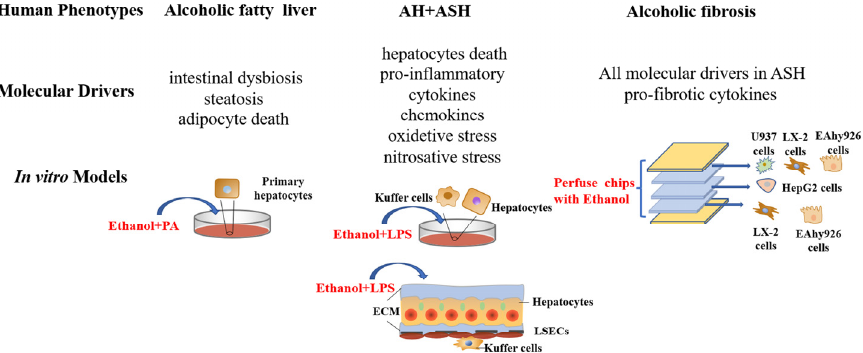
Figure 2. Commonly used in vitro models of ALD at different stages. ASH, alcoholic steatohepatitis; AH, alcoholic hepatitis; Ethanol + PA, ethanol plus palmitic acid; Ethanol + LPS, ethanol plus palmitic acid; ECM, extracellular